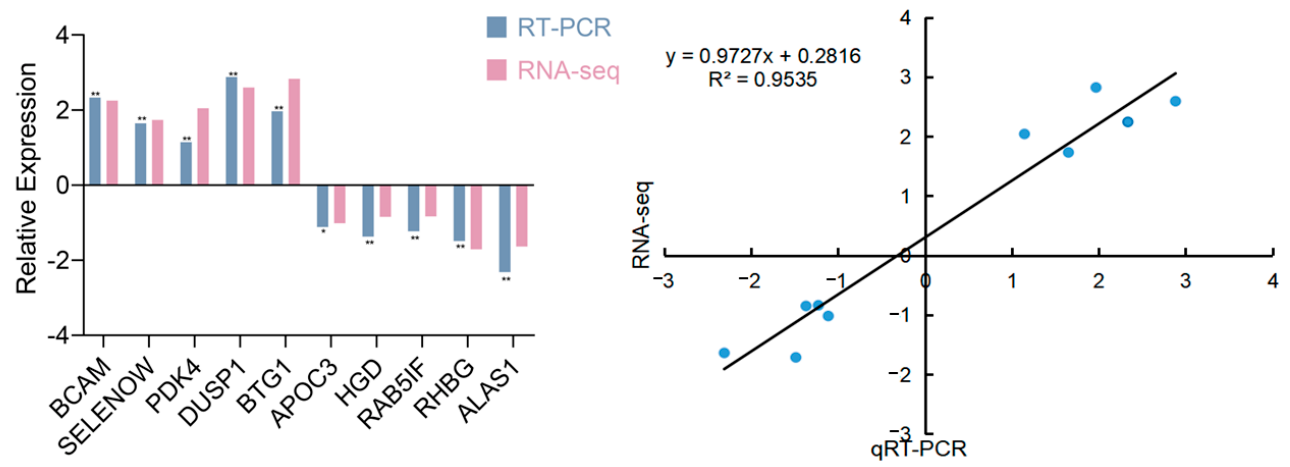
Figure 5. Validation of RNA-Seq results via Quantitative Reverse–Transcription PCR (qRT-PCR). The significant differences (* p < 0.05; ** p < 0.01) were performed using two-tailed unpaired t -test.